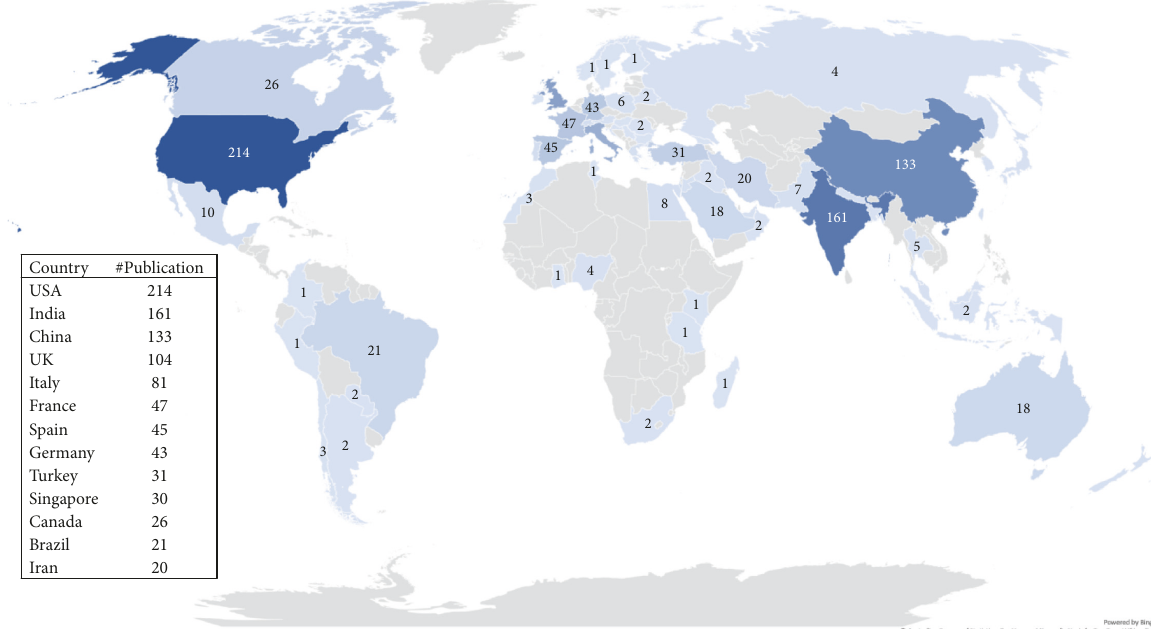
Figure 2: The worldwide distribution of publications across the countries. Countries with higher than 20 publications were shown in the box (USA: United States of America, UK: United Kingdom).